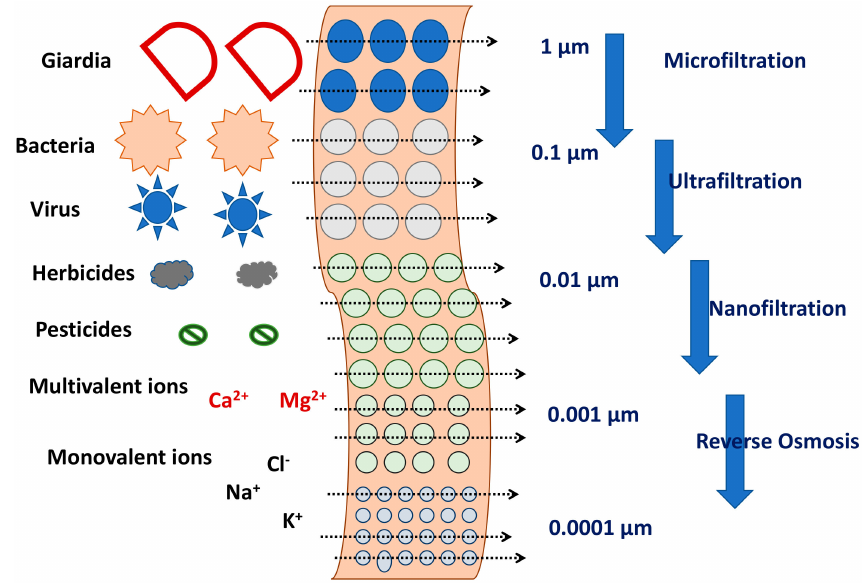
Figure 7. Sieving of ECs through membranes with different pore